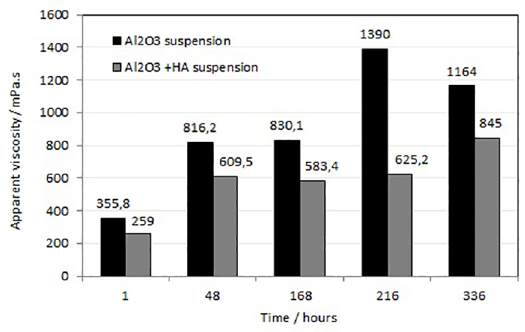
Figure 5. Apparent viscosity variation as a function of rest time. Constant shear rate of 75 s -1 . pH 11.